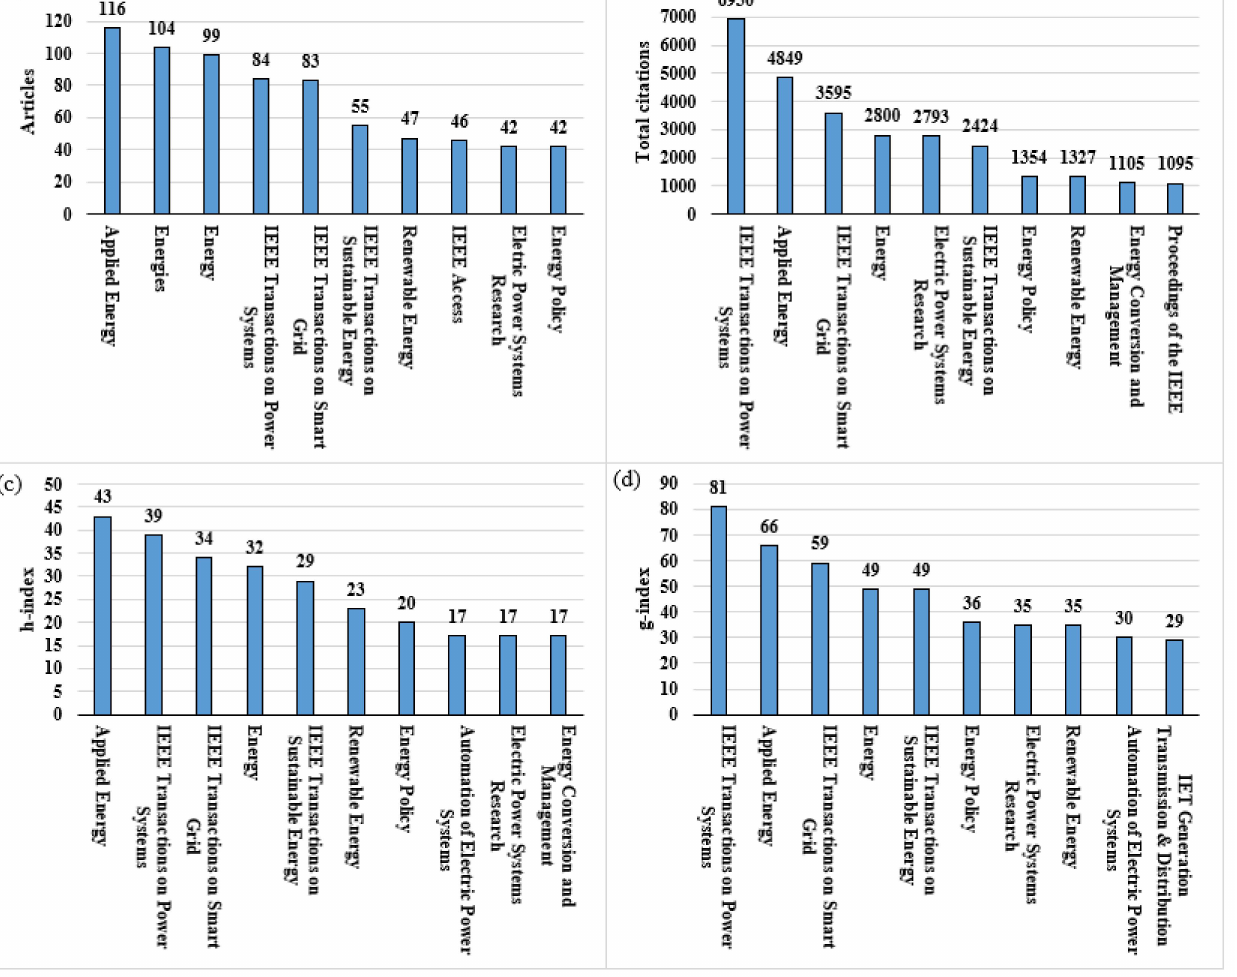
Figure 3. Main article sources by ( a ) the number of published articles, ( b ) total citations, ( c ) h index, and ( d ) g index. Source: own study using data from